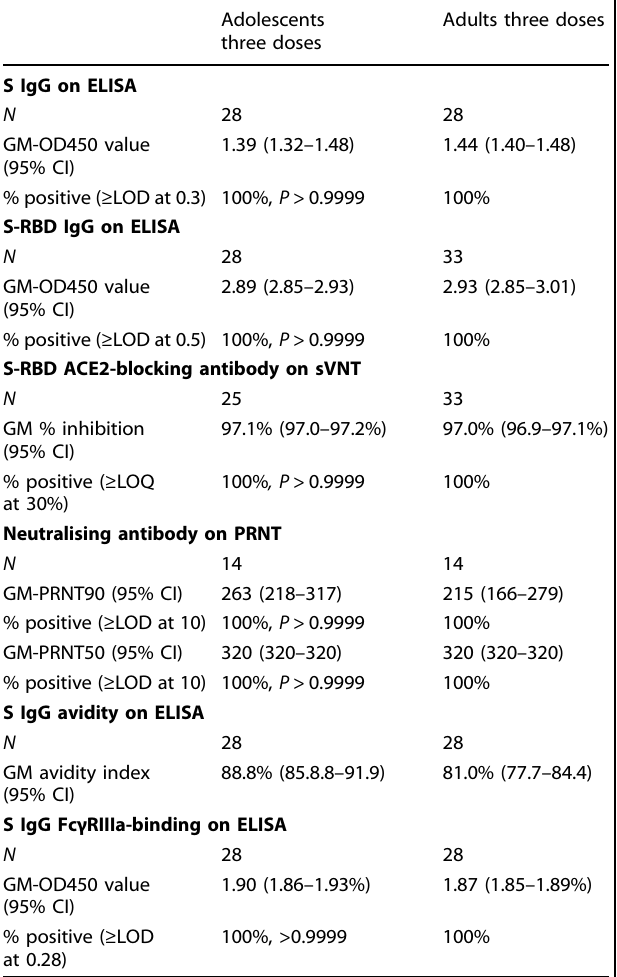
Table 1. Humoral immunogenicity outcomes against wild-type SARS- CoV-2 after the third dose of BNT162b2 in the evaluable analysis population Adolescents three